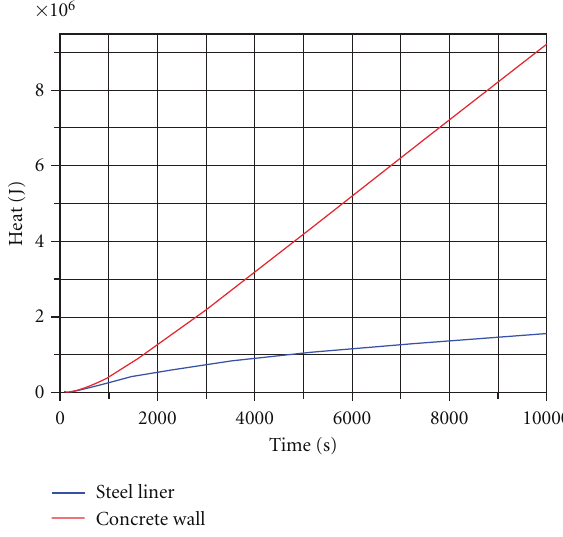
Figure 7: Heat accumulated in the wall’s structural parts during the severe